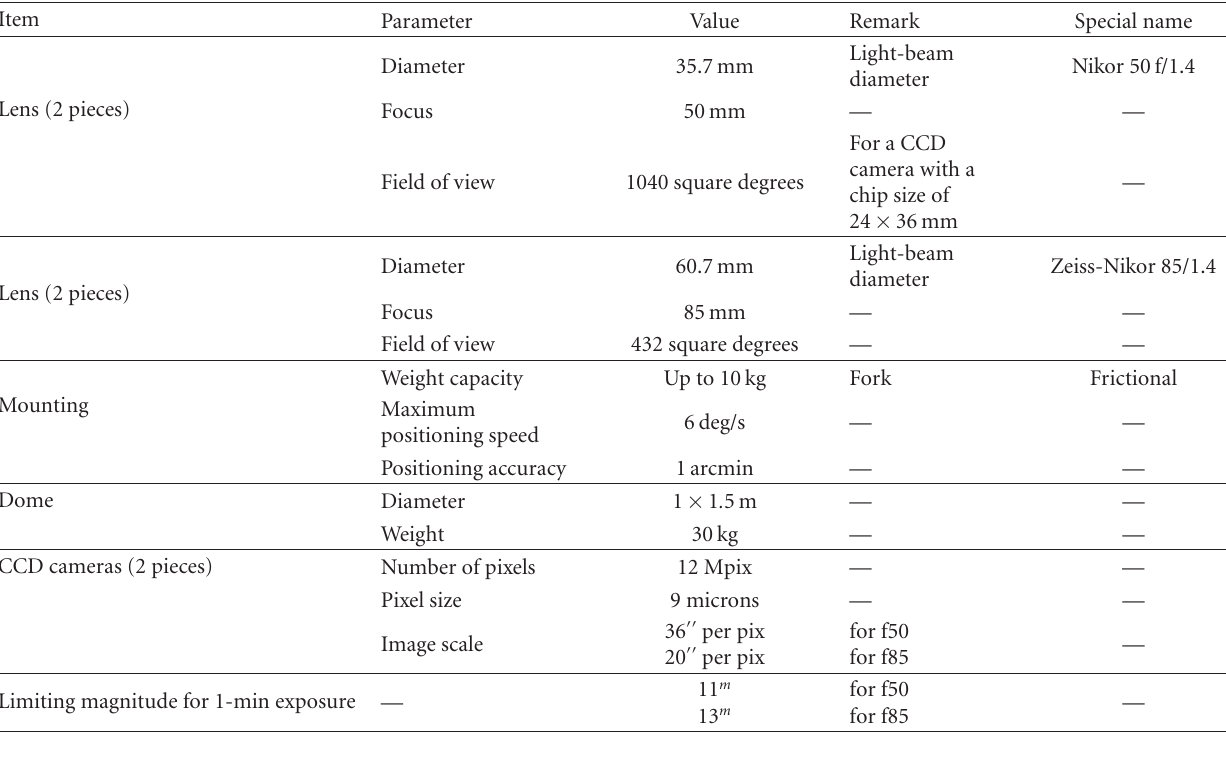
Table 2: Composition and specification of MASTER VWF camera.